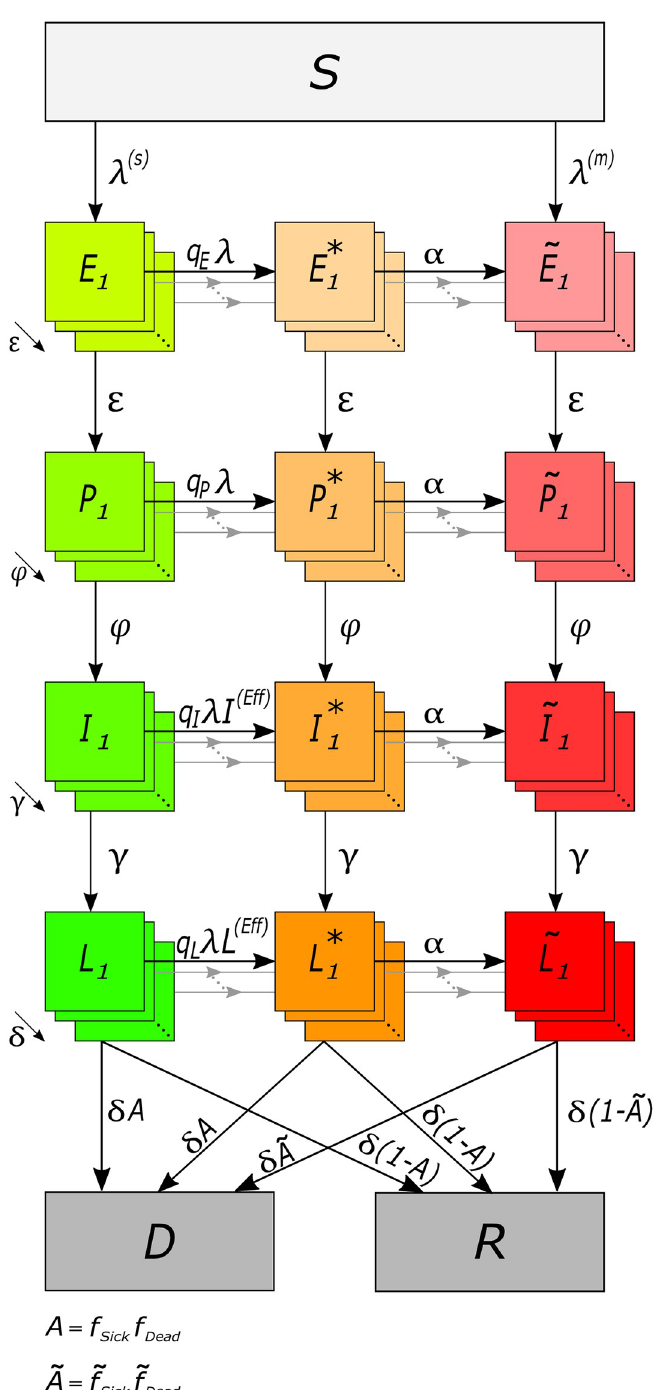
Fig 1. Model illustration. Model compartments are shown as boxes. Grey boxes illustrate susceptible ( S ), recovered ( R ), and dead ( D ) individuals. Green boxes illustrate single-infections, orange boxes multi-infections in the transient phase, and red boxes multi-infections characterized by higher morbidity and mortality. Infected compartments consist of latent infected ( E ), prodromal ( P ), fully contagious ( I ), and late infectious ( L ) Erlang sub-states. Arrows indicate k k k k flows between compartments at the various